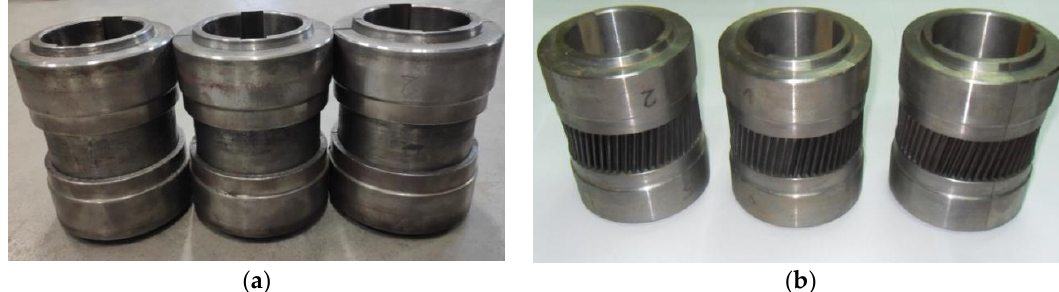
Figure 9. Tools used in the rotary compression of hollow gear shafts: ( a ) rollers with smooth steps used in Operation 1, ( b ) rollers with gears on the central step used in Operation 2.